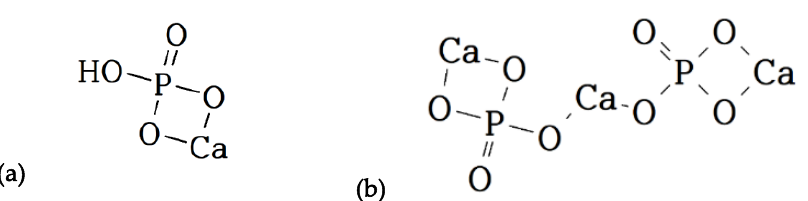
Figure 1. The structural formula of ( a ) calcium phosphate dibasic (DCP) and ( b ) calcium phosphate tribasic